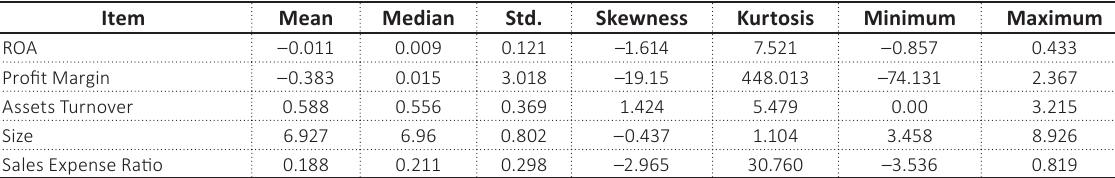
Table 2. Descriptive